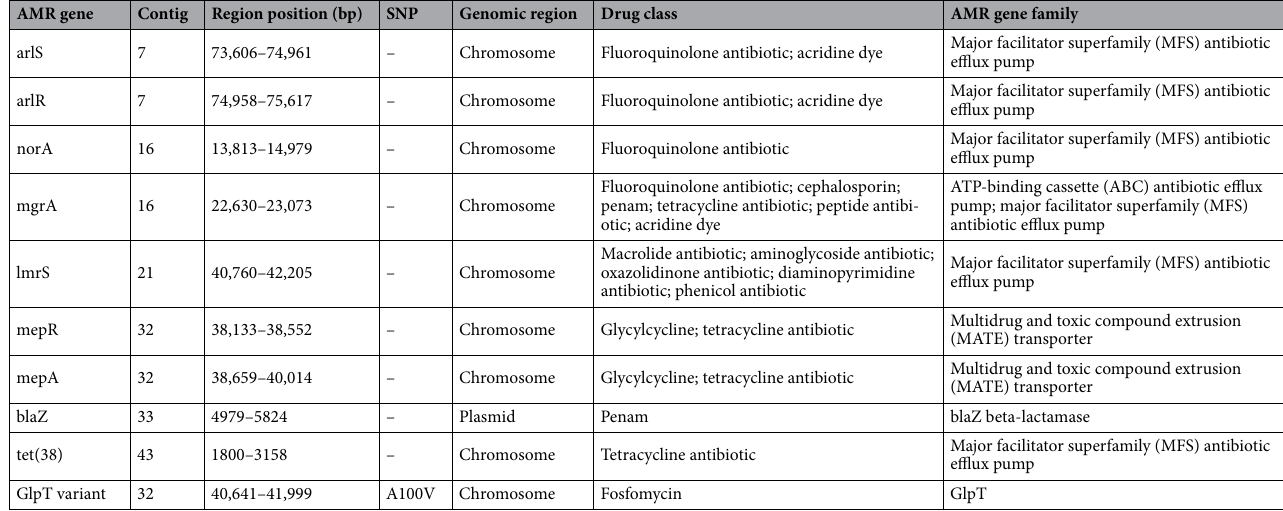
Table 2. Antimicrobial resistance-conferring genes identified in the HS-MSSA